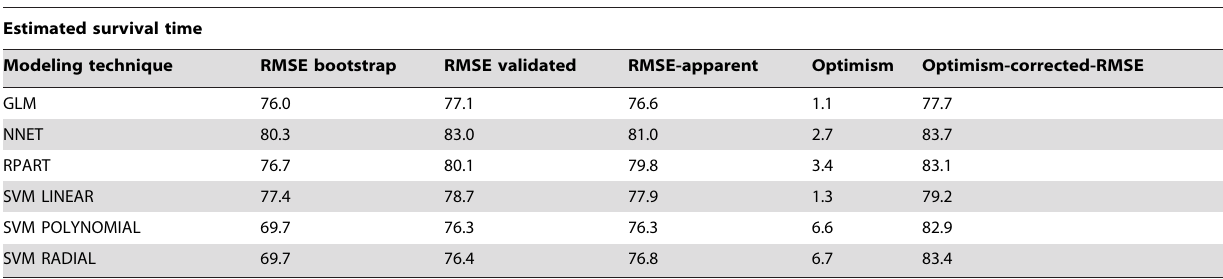
Table 5. Performance of models for the outcome ‘estimated survival time’.